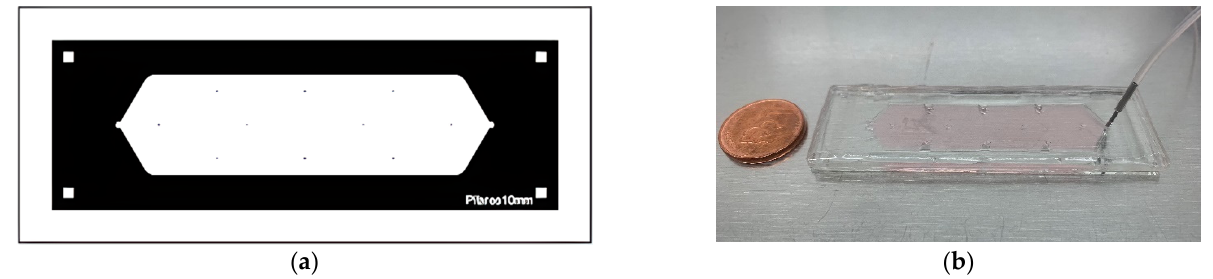
Figure 2. The PDMS device used during experiments. ( a ) Design view; ( b ) Physical view.